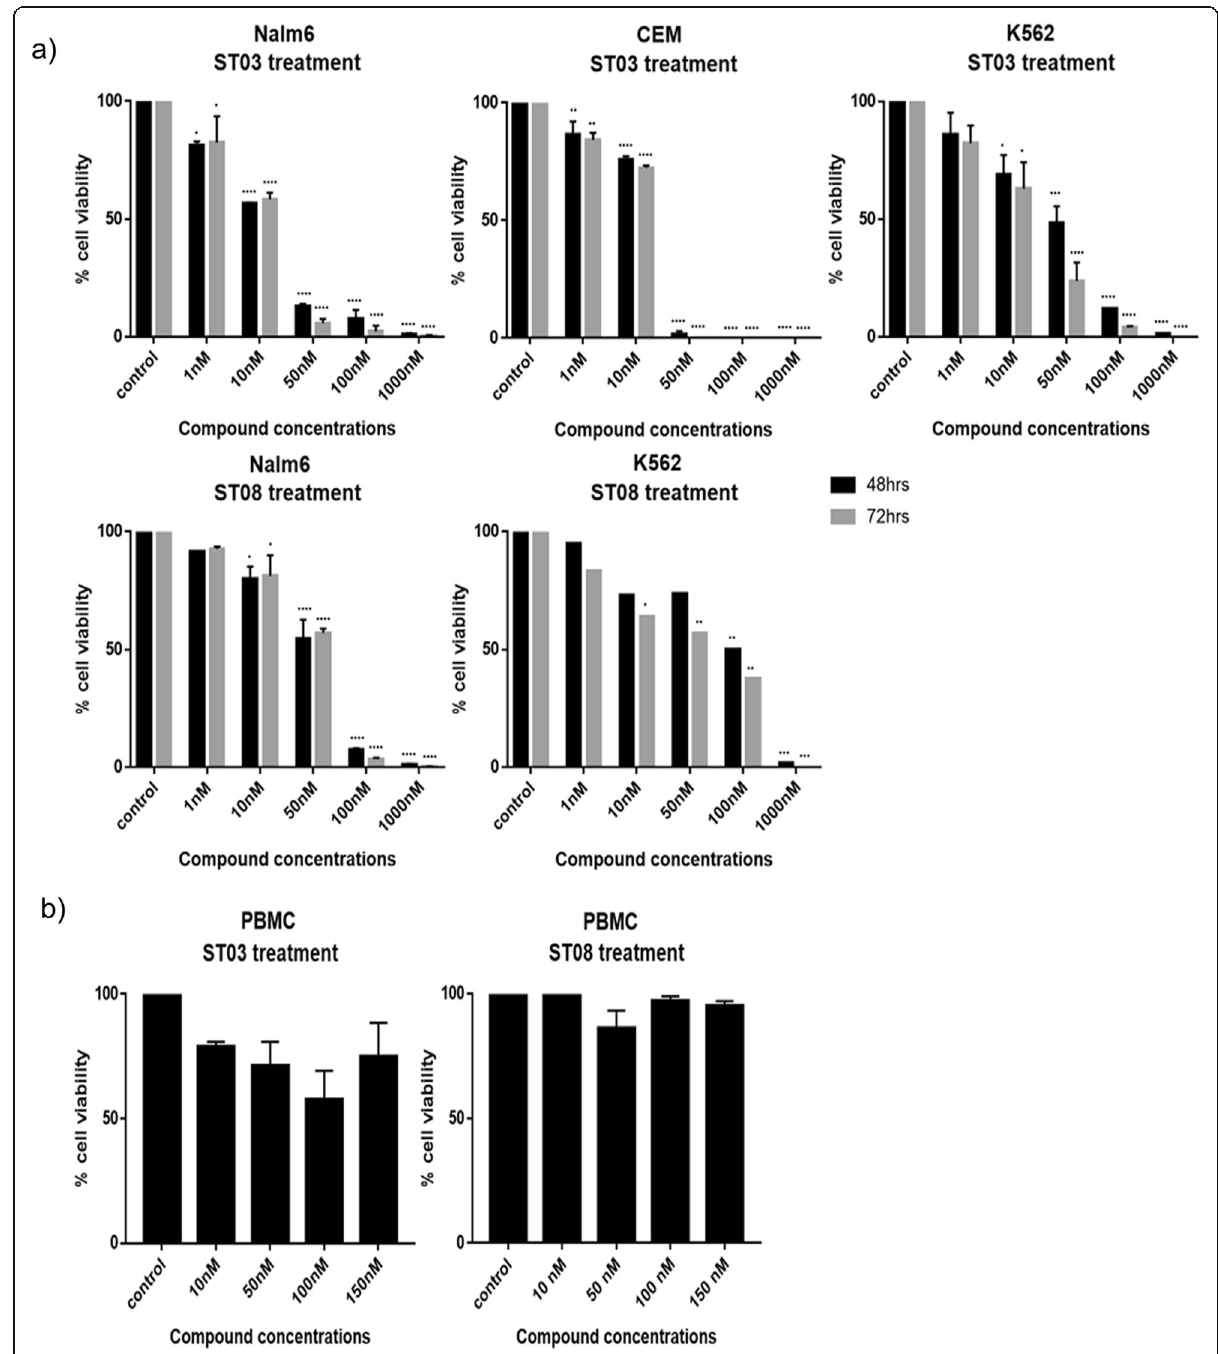
Fig. 2 Evaluation of effect of ST03 and ST08 on cancer cell lines and PBMCs by Trypan Blue exclusion assay. a Viable cells after ST03 (Nalm6, CEM, K562) and ST08 (Nalm6, K562) treatment b Viable PBMC cell count after ST03 and ST08 treatments. Each experiment was repeated for a minimum of 3 times and plotted as bar graphs with error bars. Two-way ANOVA was conducted using Graph pad prism 7 tool and the p value was calculated between control and ST compound treated samples, where, *: p value < 0.05, **: p value < 0.005, ***: p value < 0.0001, ****: p value <